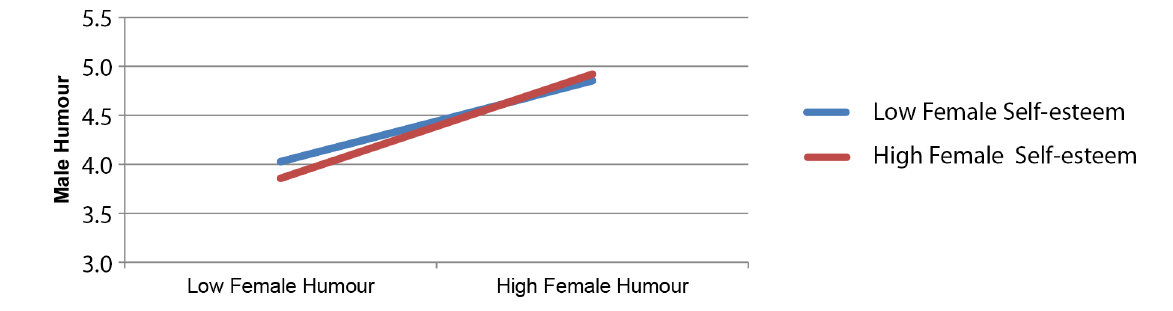
Figure 2. Moderation effects of female self-esteem in the association between female humour (predictor) and male humour